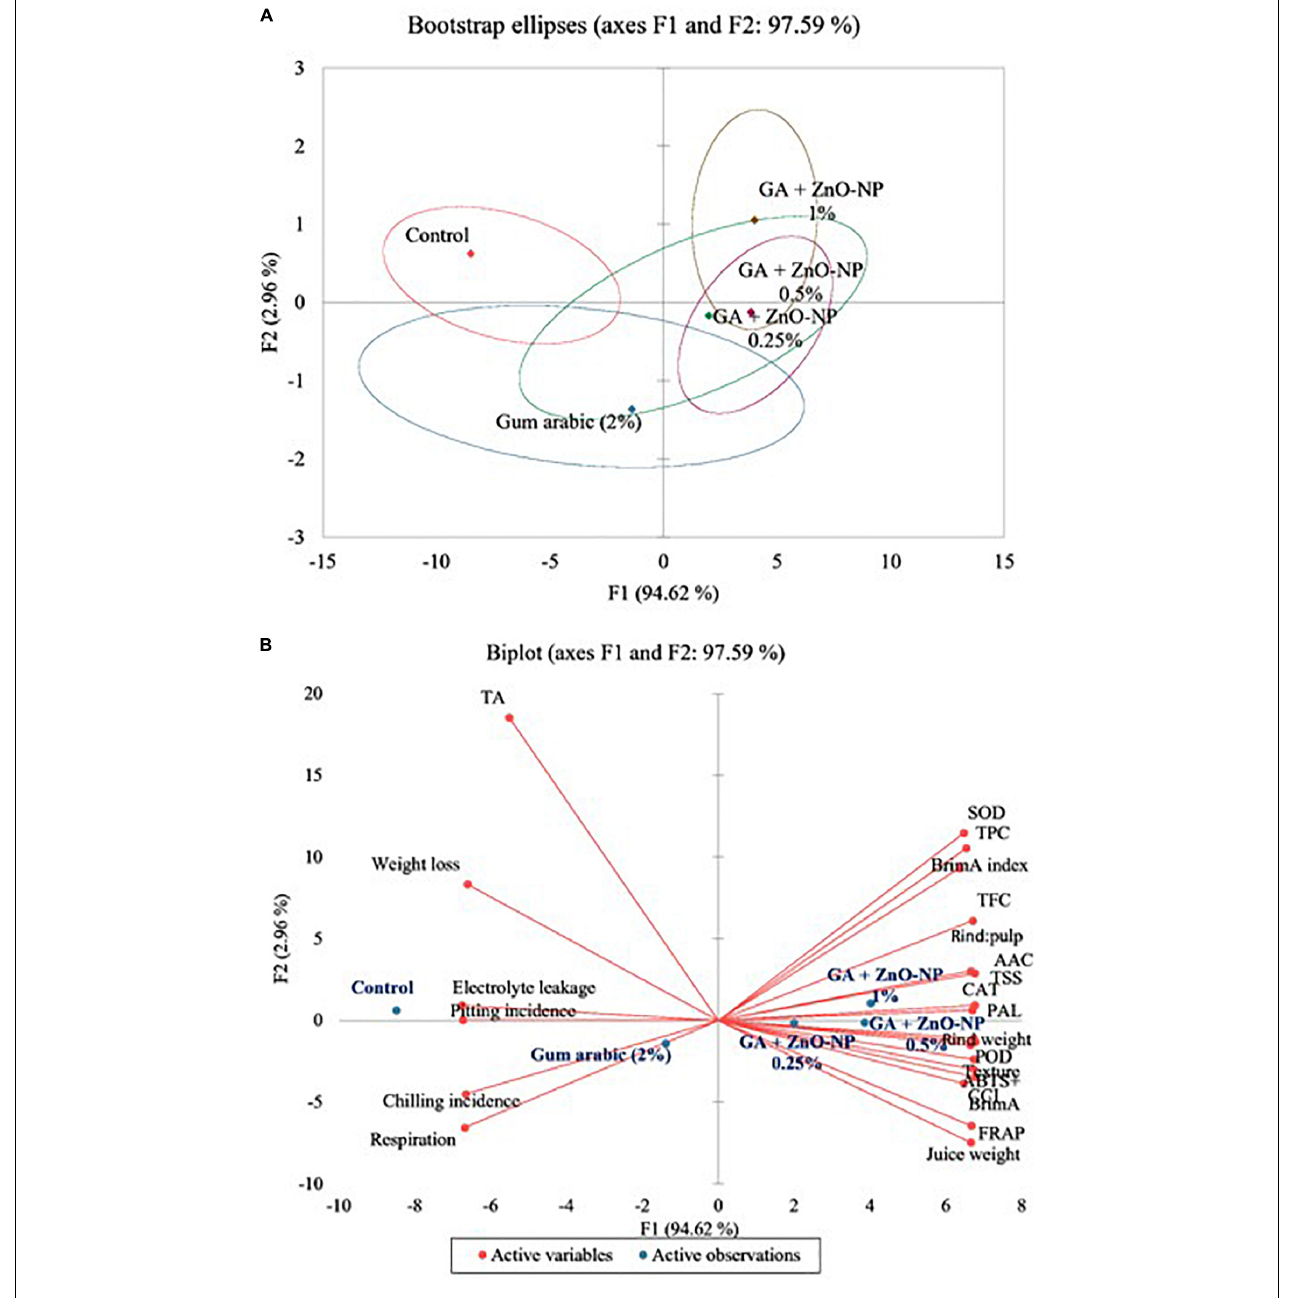
FIGURE 12 | (A) Bootstrap ellipses of variance explained by each factor of the principal component and (B) principal component analysis showing active variables and observations for ‘Kinnow’ mandarin fruit. Data obtained at day 40 was used to generate the PCA.